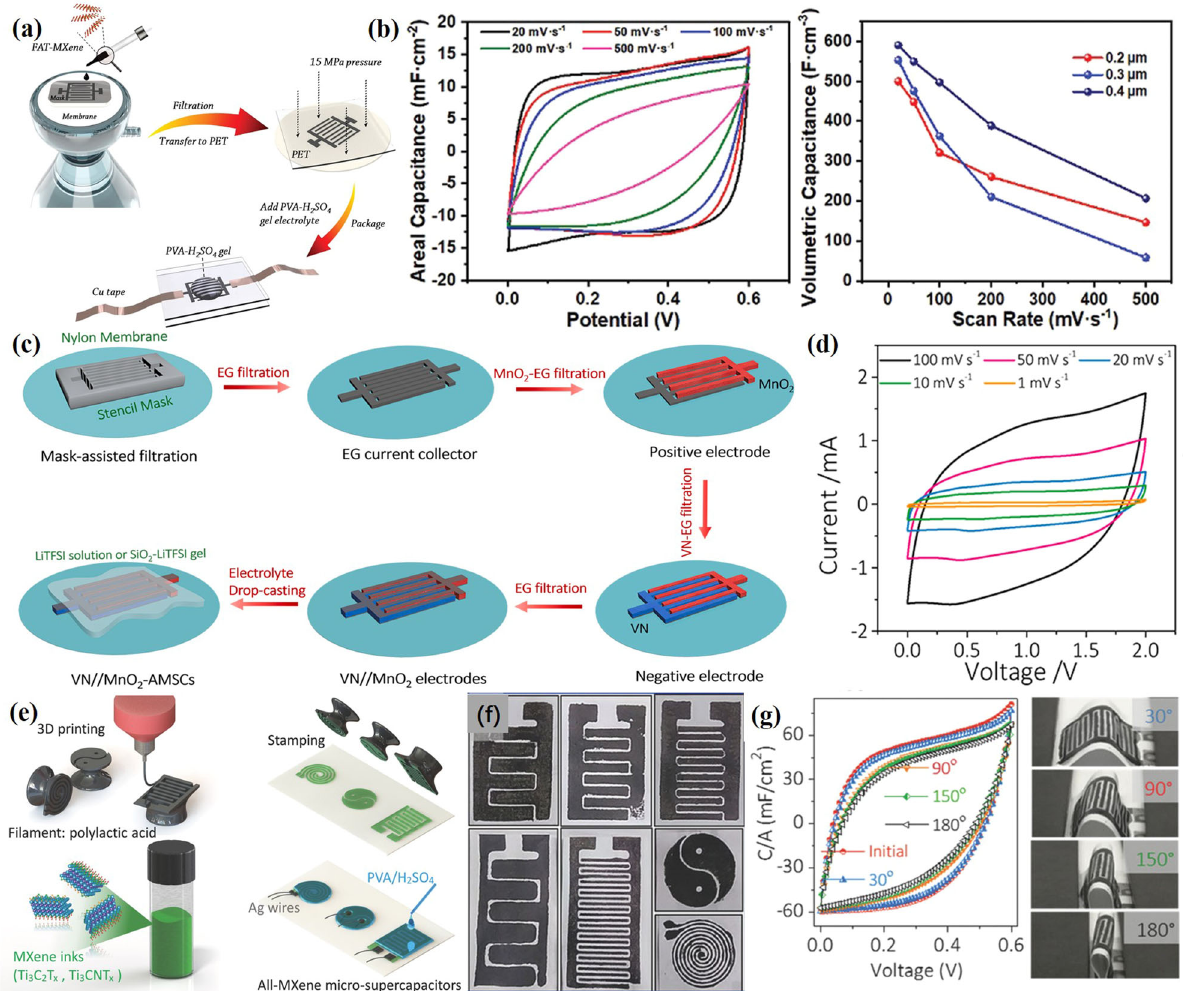
Fig. 4 Fabrication of MSCs by mask-assisted fi ltering and stamping. a The schematic diagram of the mask-assisted fabrication of all-MXene MSC. b CV curves at different scan rates (left) and the volumetric capacitances of the MSCs with different thicknesses (right). c Fabrication of VN//MnO 2 -AMSCs by mask-assisted fi ltration. d CV curves measured at different scan rates of the device. e Fabrication process of all-MXene- based MSCs through the stamping strategy. f Photos of the MSCs with various architectures. g CV curves of as-stamped MSCs under different bended states. a , b Reproduced with permission 72 (Copyright © 2020, John Wiley and Sons). c , d Reproduced with permission 73 (Copyright © 2019, Elsevier). e – g Reproduced with permission 75 (Copyright © 2018, John Wiley and